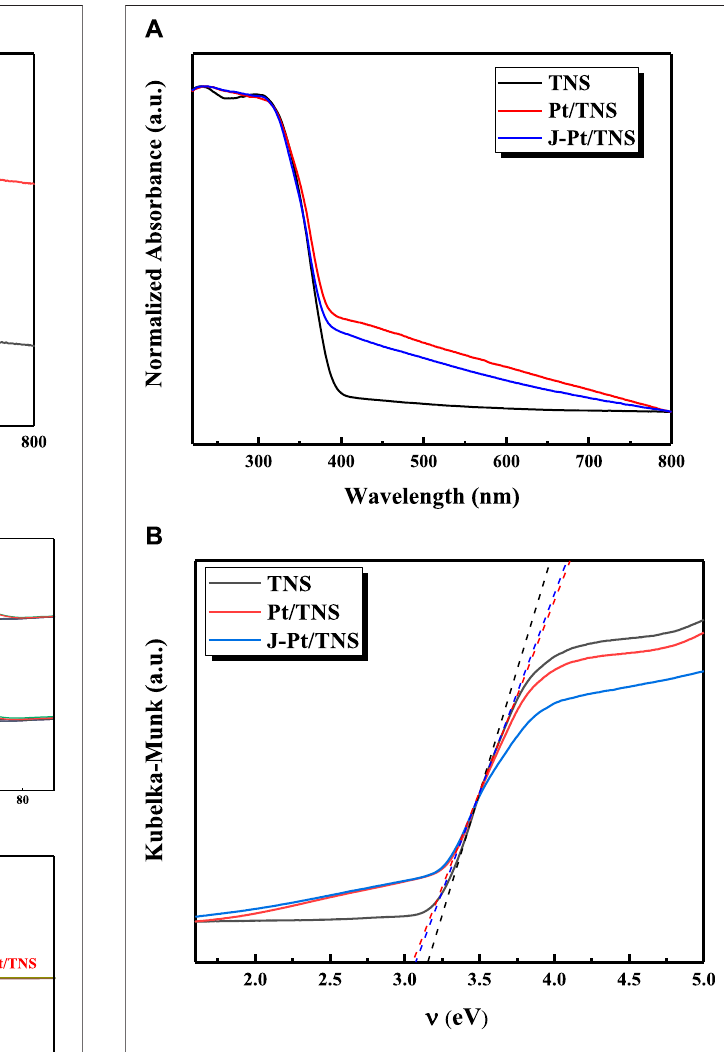
FIGURE 6 | (A) UV-vis spectrum and (B) Tauc plot of the as-prepared